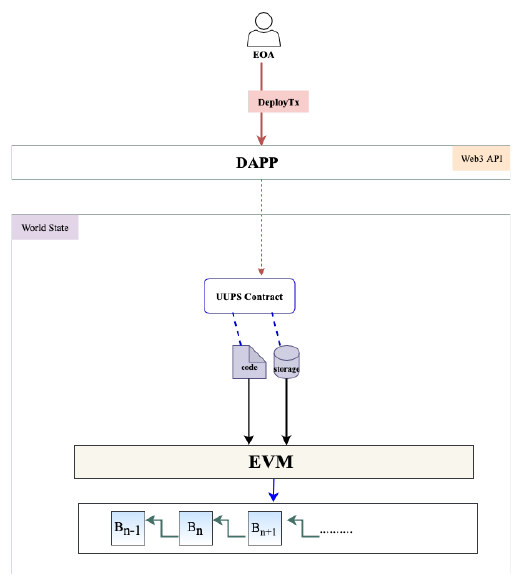
Figure 8. Process of deploying the UUPSUpgradeable